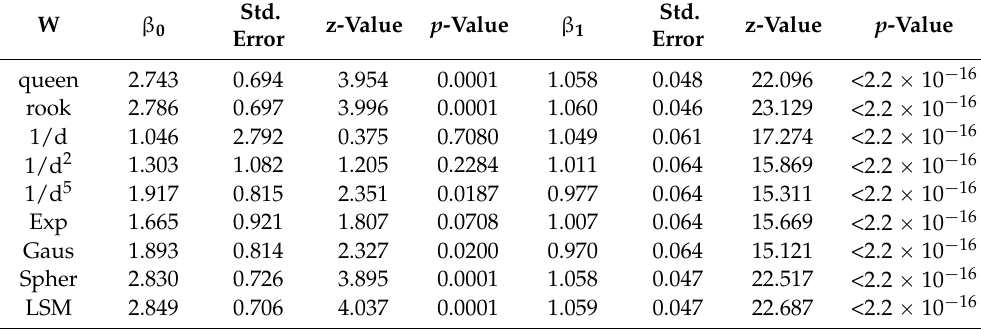
Table 5. Model coefficient estimates of spatial Durbin model (SDM) for nine spatial weight matrices.